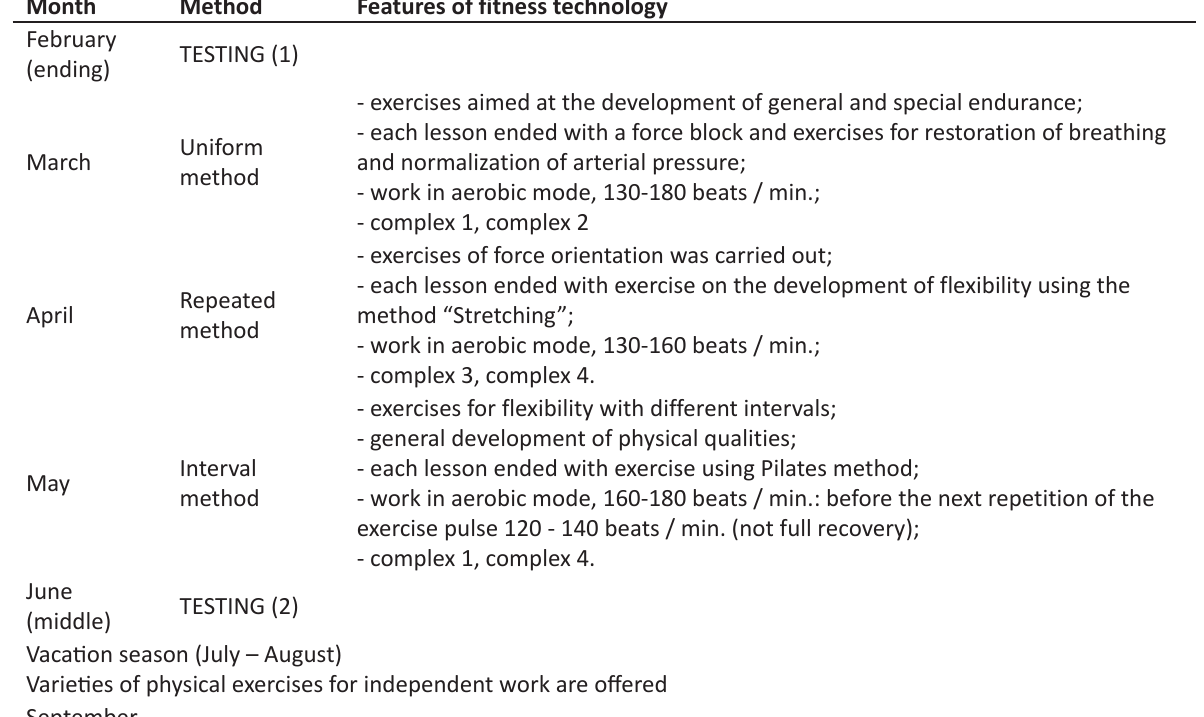
Table 1. Methodology of use fitness technology for girls aged 17-20 years Month Method Features of fitness